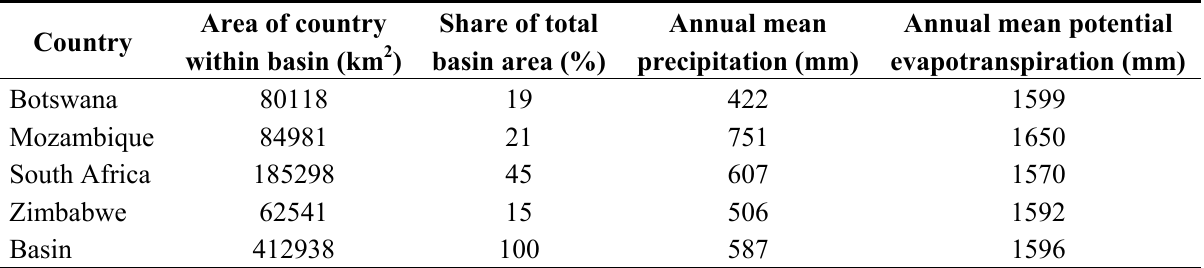
Table 1. Characteristics of the Limpopo River Basin catchments in riparian countries.